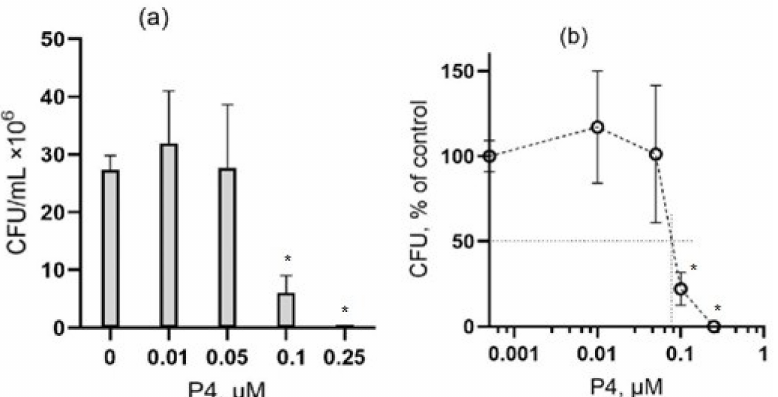
Figure 2. The dose-dependent effect of peptide P4 on the viability of Gram-positive bacteria B. subtilis (strain 168). ( a ) The number of colonies (CFU, colony-forming units, number of cells/mL) that were found after the incubation period of exponentially growing bacterial cells in the presence of peptide P4 at a concentration rate from 0 to 0.25 µ M. All samples contained 1% DMSO and 1 mg/mL albumin (see “Materials and Methods”). ( b ) The dose-response curve shows the effect of peptide P4 in the experiment illustrated in panel ( a ); the number of colonies that were found in the absence of the peptide was taken as 100%. * The difference from the control value is statistically significant at p ≤